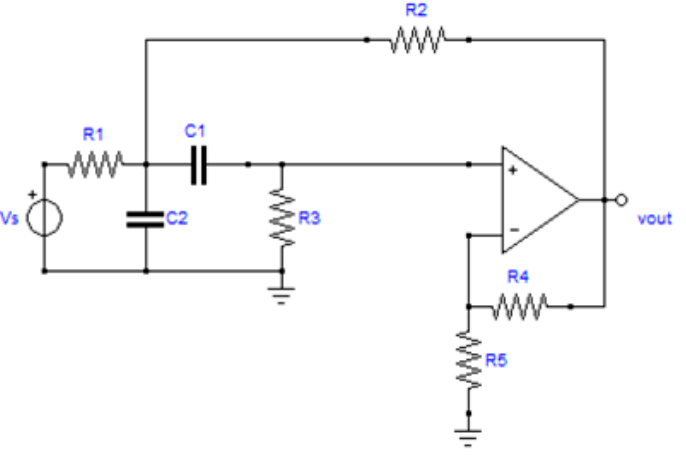
Figure 2. Schematic of the Sallen-Key filter (SKF).